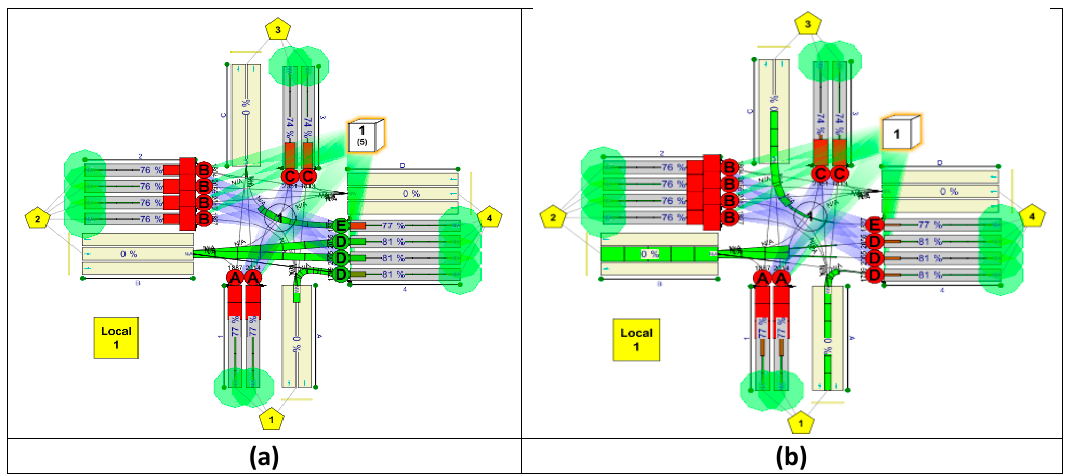
Figure 12. Simulation results for the morning-peak period. Simulation time ( a ) 60 s; ( b ) 65 s.